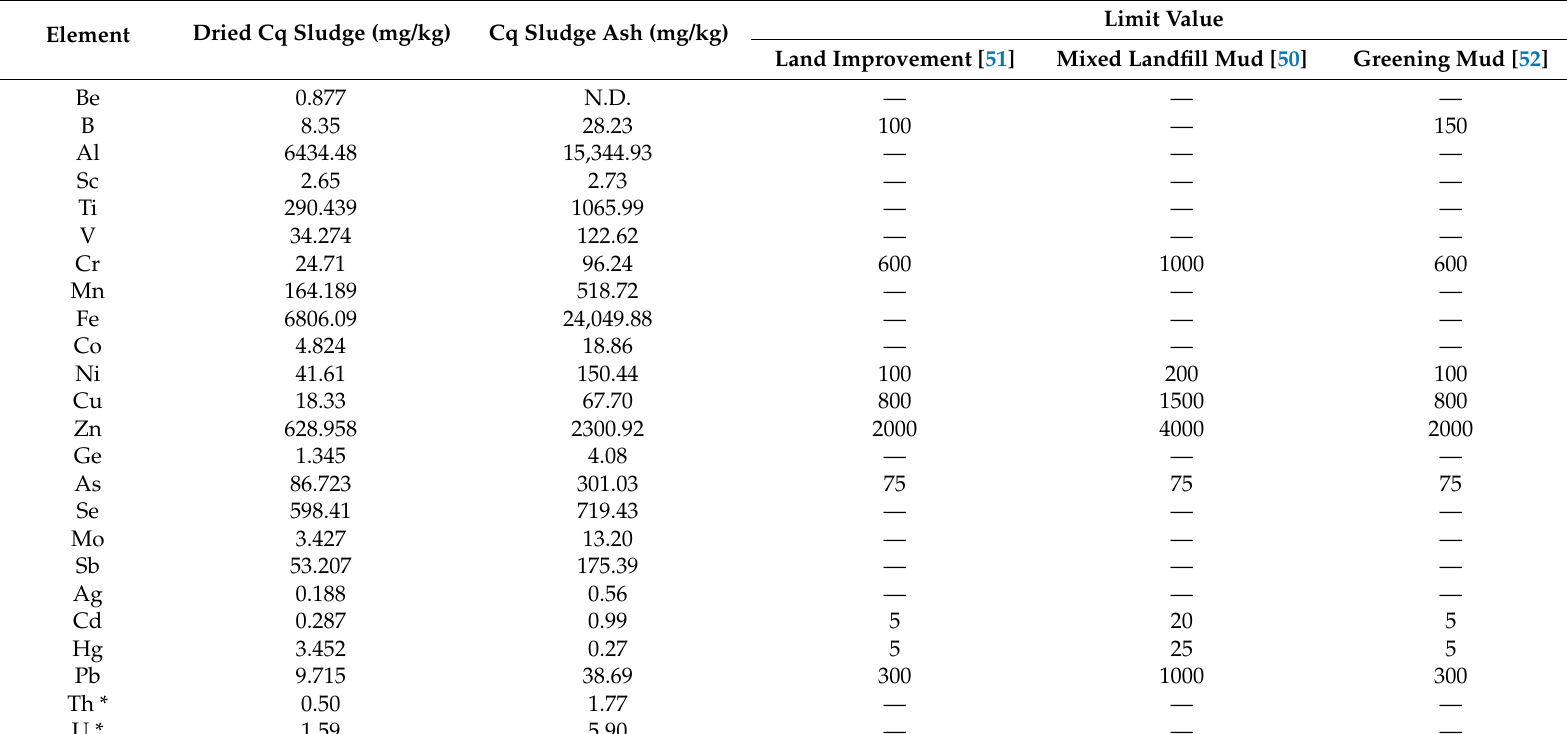
Table 5. Element content of Cq sludge